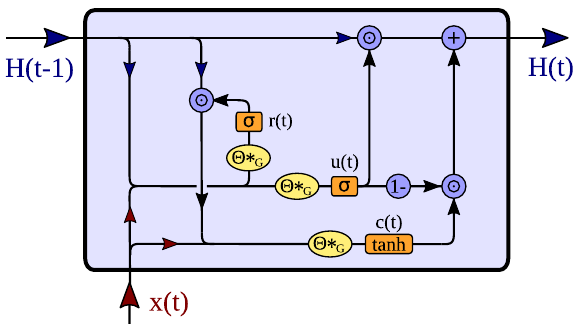
Figure 6. Overview of the processing steps of the DCGRU cell. The input x ( t ) , as well as the previous hidden state H ( t − 1 ) are concatenated and passed to the reset gate r ( t ) , as well as to the update gate u ( t ) . The reset gate r ( t ) controls the proportion of H ( t − 1 ) which enters c ( t ) , together with input x ( t ) . Then the hidden state H ( t − 1 ) is updated by c ( t ) , whereby the amount of new information is controlled by u ( t )